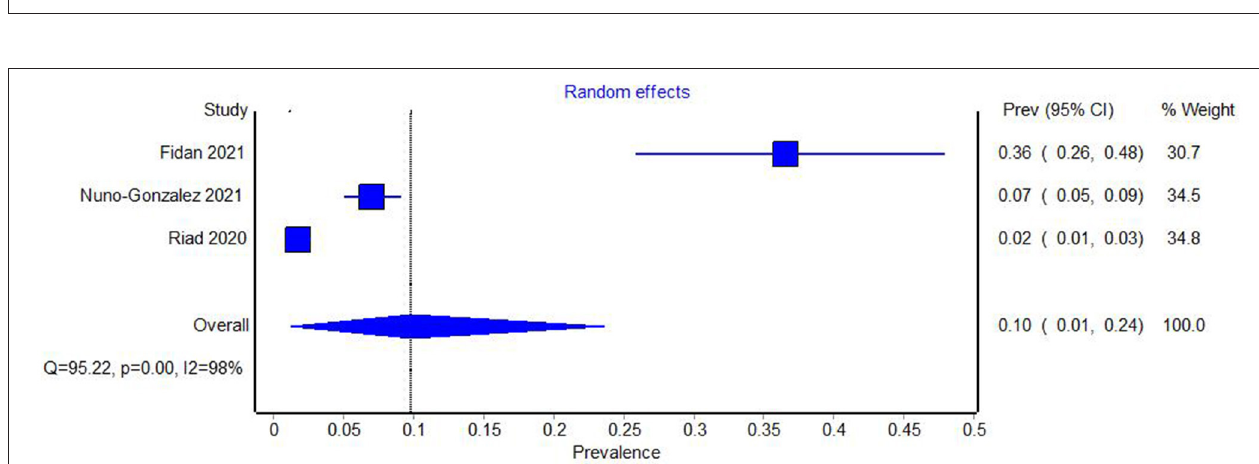
FIGURE 4 | Forest plot showing the pooled prevalence of aphthous oral lesions in COVID-19, with studies at high risk of bias included.